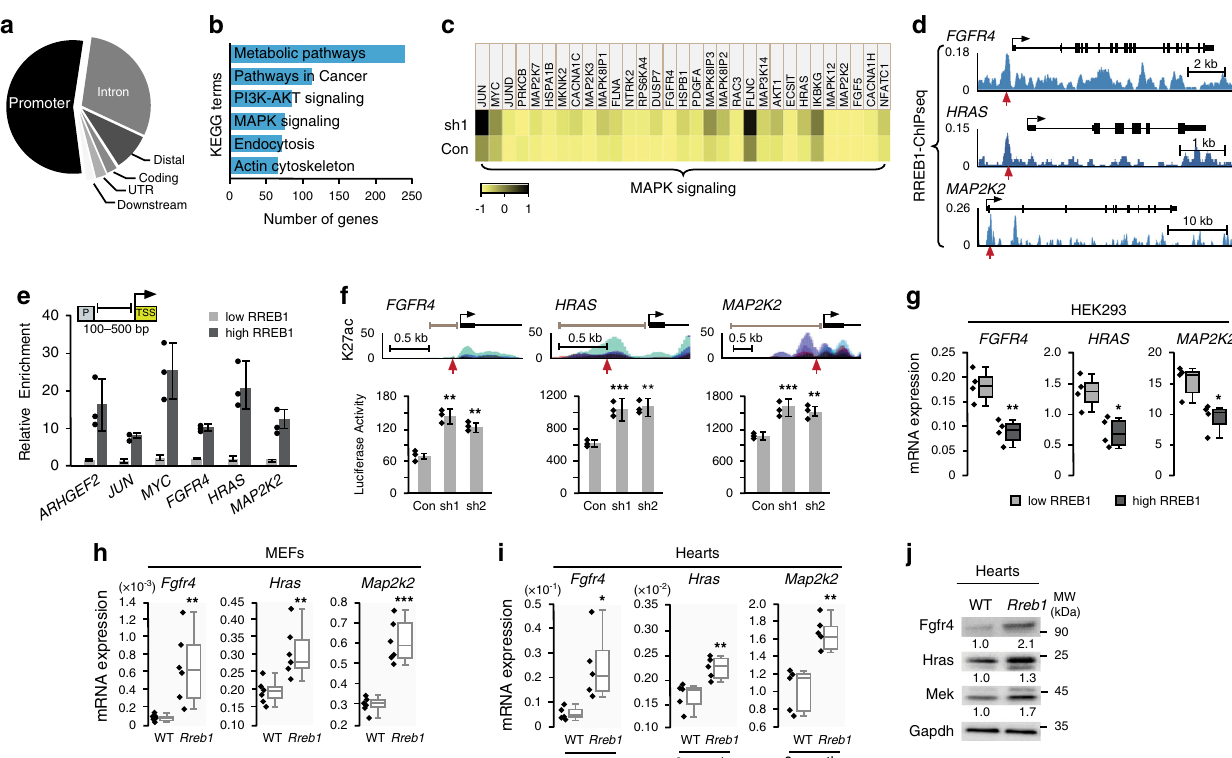
Fig. 3 RREB1 transcriptionally regulates MAPK pathway target genes. a Genomic distribution of RREB1 ChIP-seq peaks. Distal (intergenic), UTR (5 ’ and de fi ned MAPK pathway genes differentially expressed by RNA-seq analysis in HEK293 cells expressing control shRNA (Con) versus shRNA targeting RREB1 (sh1). Color scale ranges from yellow lowest expression to black highest expression. d Gene track view of RREB1-ChIP-seq peaks at the indicated loci . Gene bodies are shown above the track sets. Black arrows of the gene bodies mark the transcription start site. Red arrows point to the RAS response element. e RREB1 ChIP-PCR in HEK293 cells with a tet-inducible RREB1 transgene treated with DMSO (low RREB1) or tetracycline to induce RREB1 expression (high RREB1). Amplicons for the indicated genes were queried around promoters (P) designed 100 – 500 bp from the TSS (inset). For this and subsequent ChIP experiments, enrichment is relative to IgG ( n = 3). Error bars presented as mean values± SD. f Upper panels depict gene track view of H3K27 acetylation (ENCODE Regulation, Layered H3K27ac track) proximal to the indicated promoters. Red arrows mark the putative RRE. Bar graphs show normalized luciferase activity (arbitrary units) driven from pGL3-reporter constructs with the indicated promoters (gray bars in the upper panels) in HEK293 cells expressing control shRNA (Con) or shRNA (sh1 or sh2) targeting RREB1 ( n = 3; ** p < 0.001, *** p < 0.0001 two - tailed student ’ s t -test,